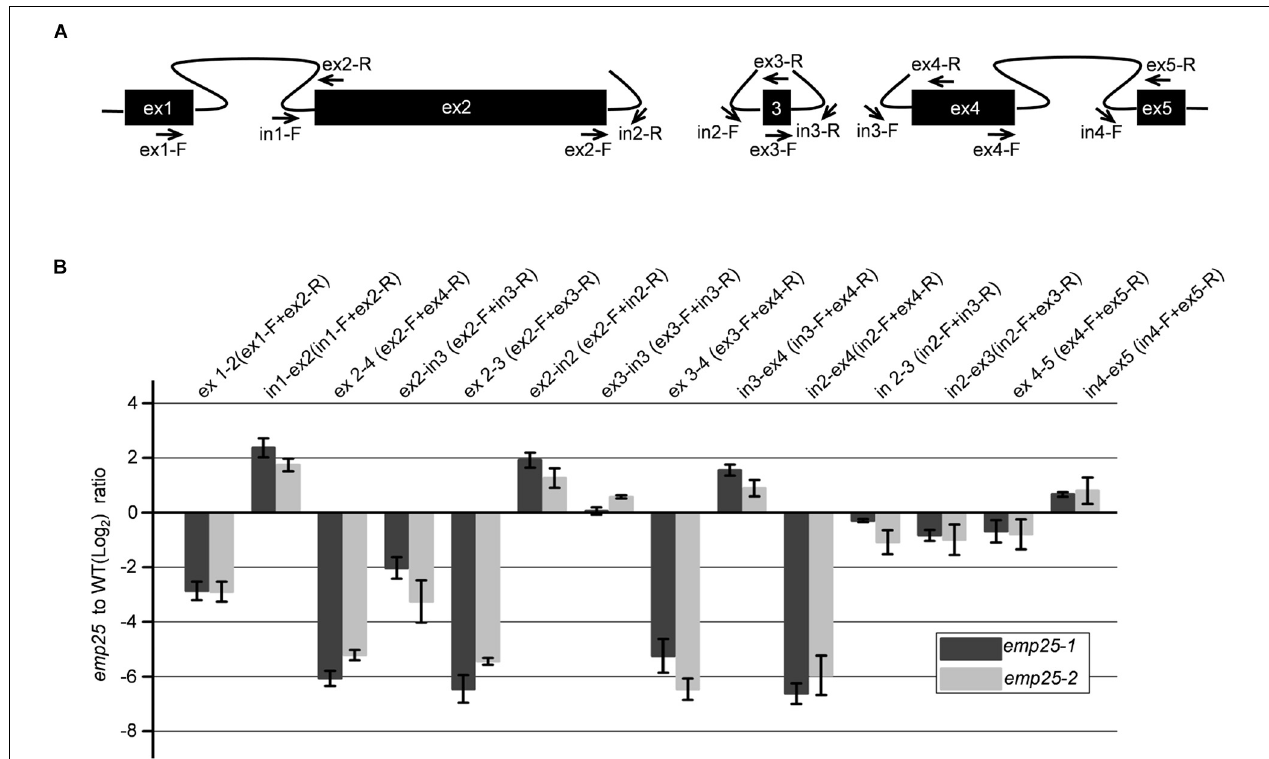
FIGURE 6 | The splicing of nad5 introns 1, 2, and 3 is impaired in emp25. (A) Diagram of the splicing events of nad5 transcript and positions of the primers used. (B) qRT-PCR analysis of the mature and unspliced transcripts of individual nad5 exons in emp25 two alleles. Values represent the mean and standard deviation of three biological